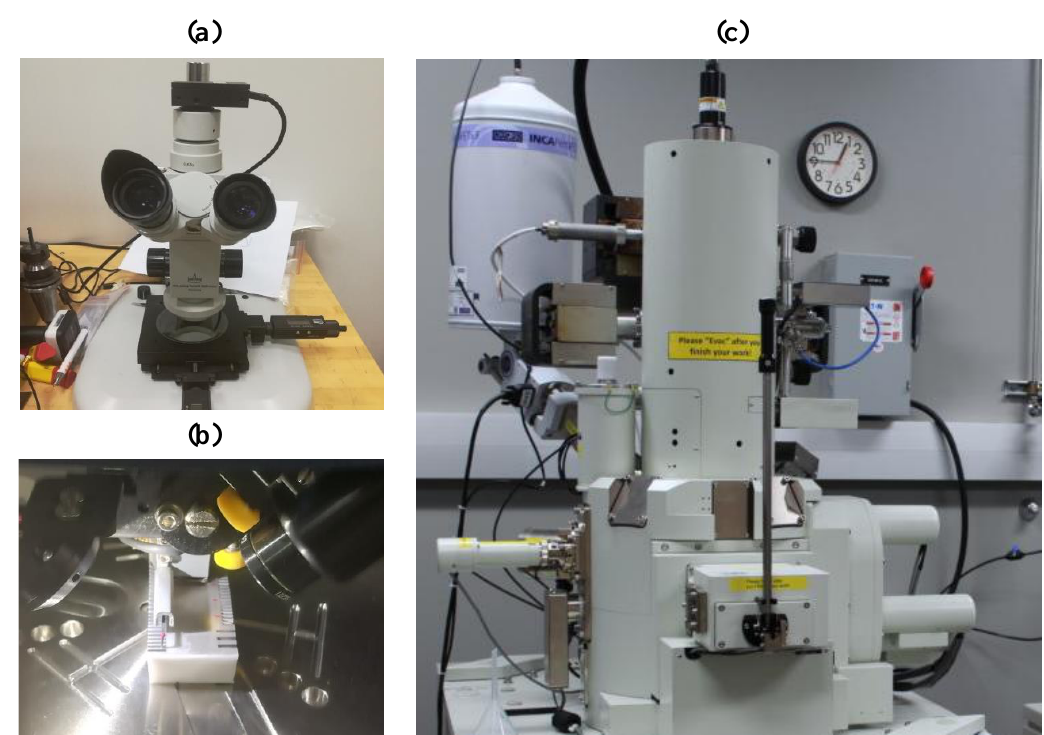
Figure 7. Measurement equipment: ( a ) optical microscope, ( b ) 3D profilometer, ( c ) SEM.